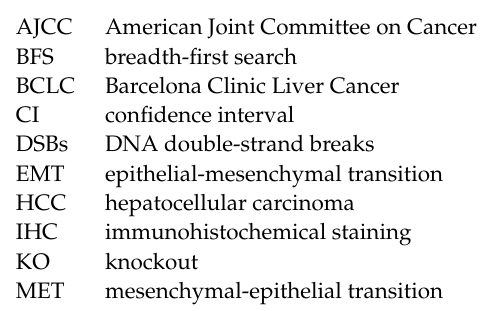
Figure S6: Global view of the hierarchy relationships of whole human pathways; Figure S7: Original Western blot images; Table S1: 295 HCC related genes; Table S2: 143 USP15-HCC genes; Table S3: 225 HCC-USP15 pathways; Table S4: Pathology scores; Tables S5: Pathways of lipid, proliferation, and